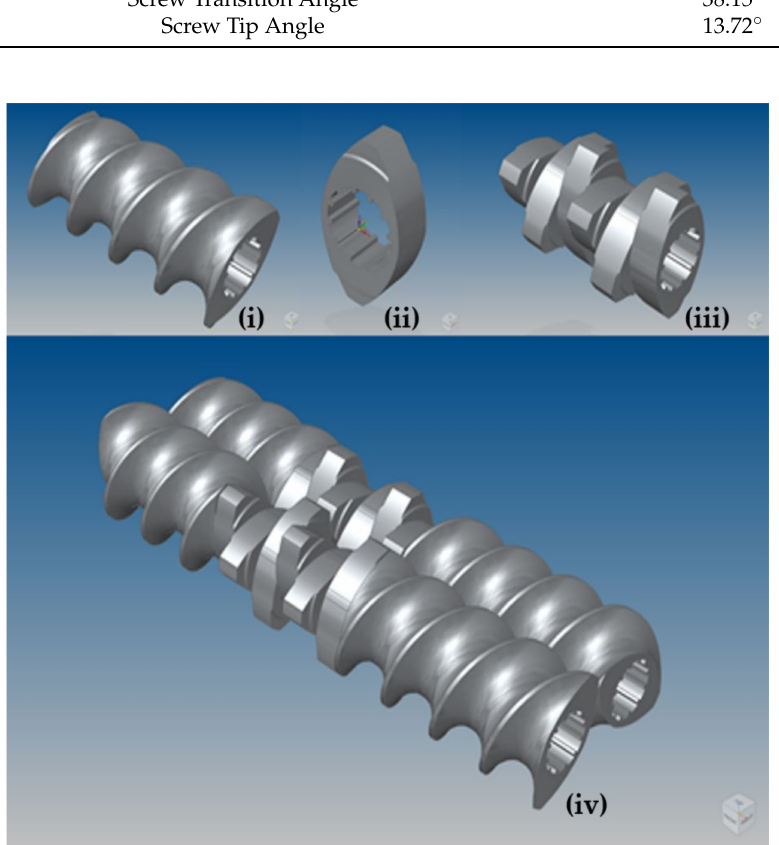
Figure 1. CAD model of ConsiGma 1 screw. Top row, from left to right: (i) Conveying element of length 37.5 mm (ii) Kneading element (iii) 6 × 60 R block of kneading elements; Bottom row: (iv) 6 × 60 R block of kneading elements with adjoining conveying